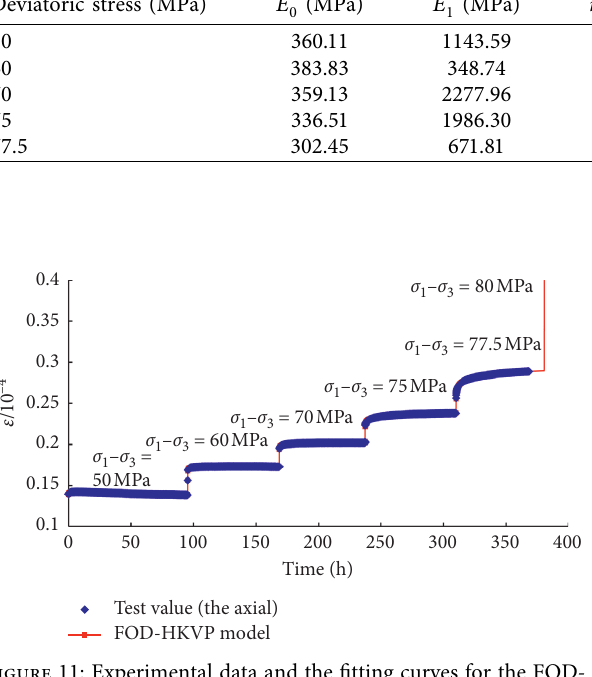
Figure 11: Experimental data and the fitting curves for the FOD- HKVP